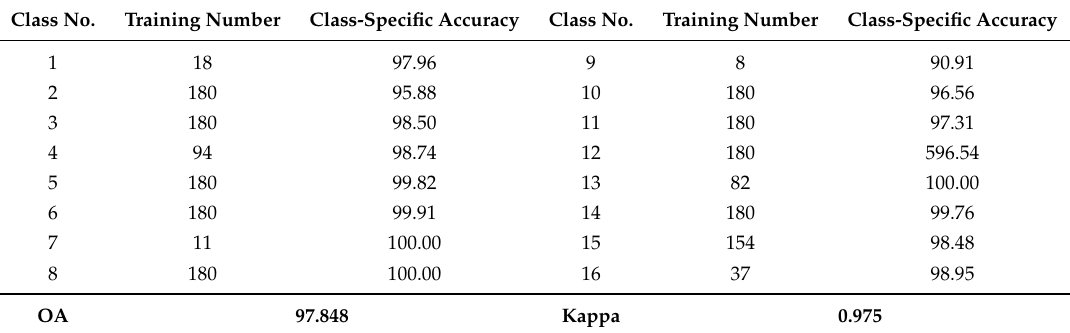
Table 11. Class-specific accuracy (%), OA (%) and Kappa coefficient of ASSP-SCNN on Indian Pines dataset with sixteen